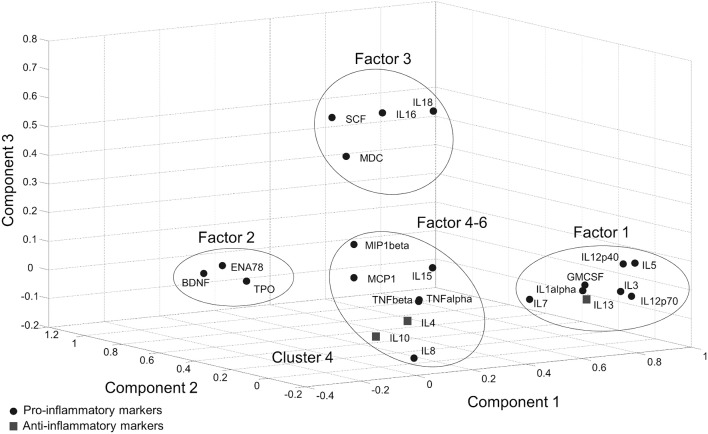
Score plot of the component values of individual inflammatory markers in PCA.